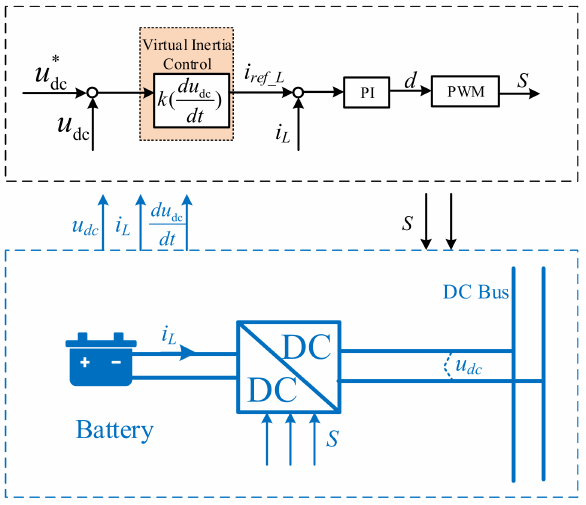
Figure 10. Control architecture for proposed AIC in Reference